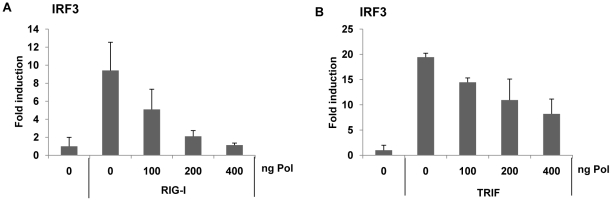
HBV Pol inhibits both RIG-I- and TRIF-induced IRF3 activation.HepG2 cells were cotransfected with increasing doses of the HBV Pol expression construct to determine the effect of HBV Pol on IRF3 signaling. To monitor IRF3 activation, cells were transfected with IRF3-GAL4 expression plasmid together with the GAL4-dependent pFR luciferase reporter construct. Note that 5-fold less amount of HBV Pol construct was used, because 24-well plate, instead of 6-well, was used. To induce IRF3 signaling, RIG-I (A) or TRIF (B) expression constructs were transfected. Data are expressed as the mean fold induction ± s .d. relative to control levels. The results are representative of at least two independent experiments, each performed in triplicate.